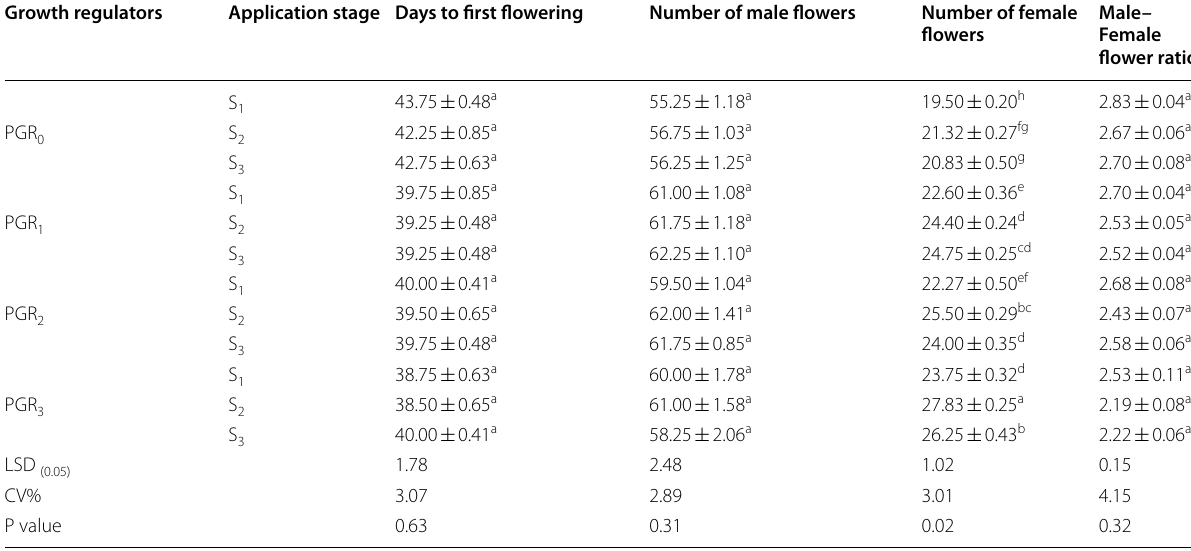
Table 2 Effect of plant growth regulators on days to flowering, number of male and female flowers (plant − 1 ) and their sex ratio at various